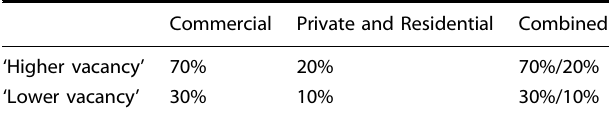
Table 1. Vacancy rates assumed in high and low vacancy scenarios and used when modelling off-street parking